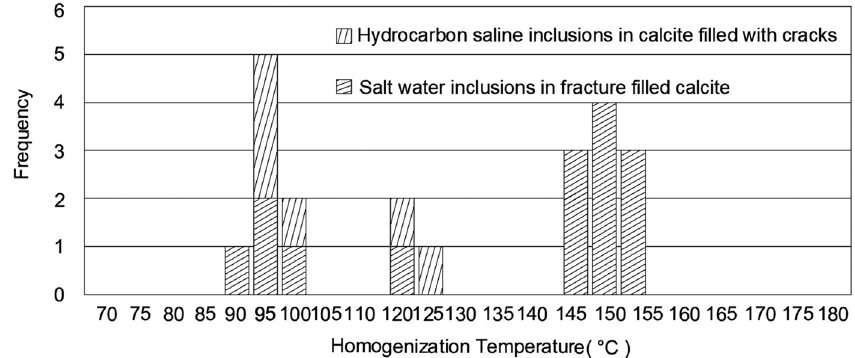
Figure 5: Histogram of inclusions homogenization temperature.